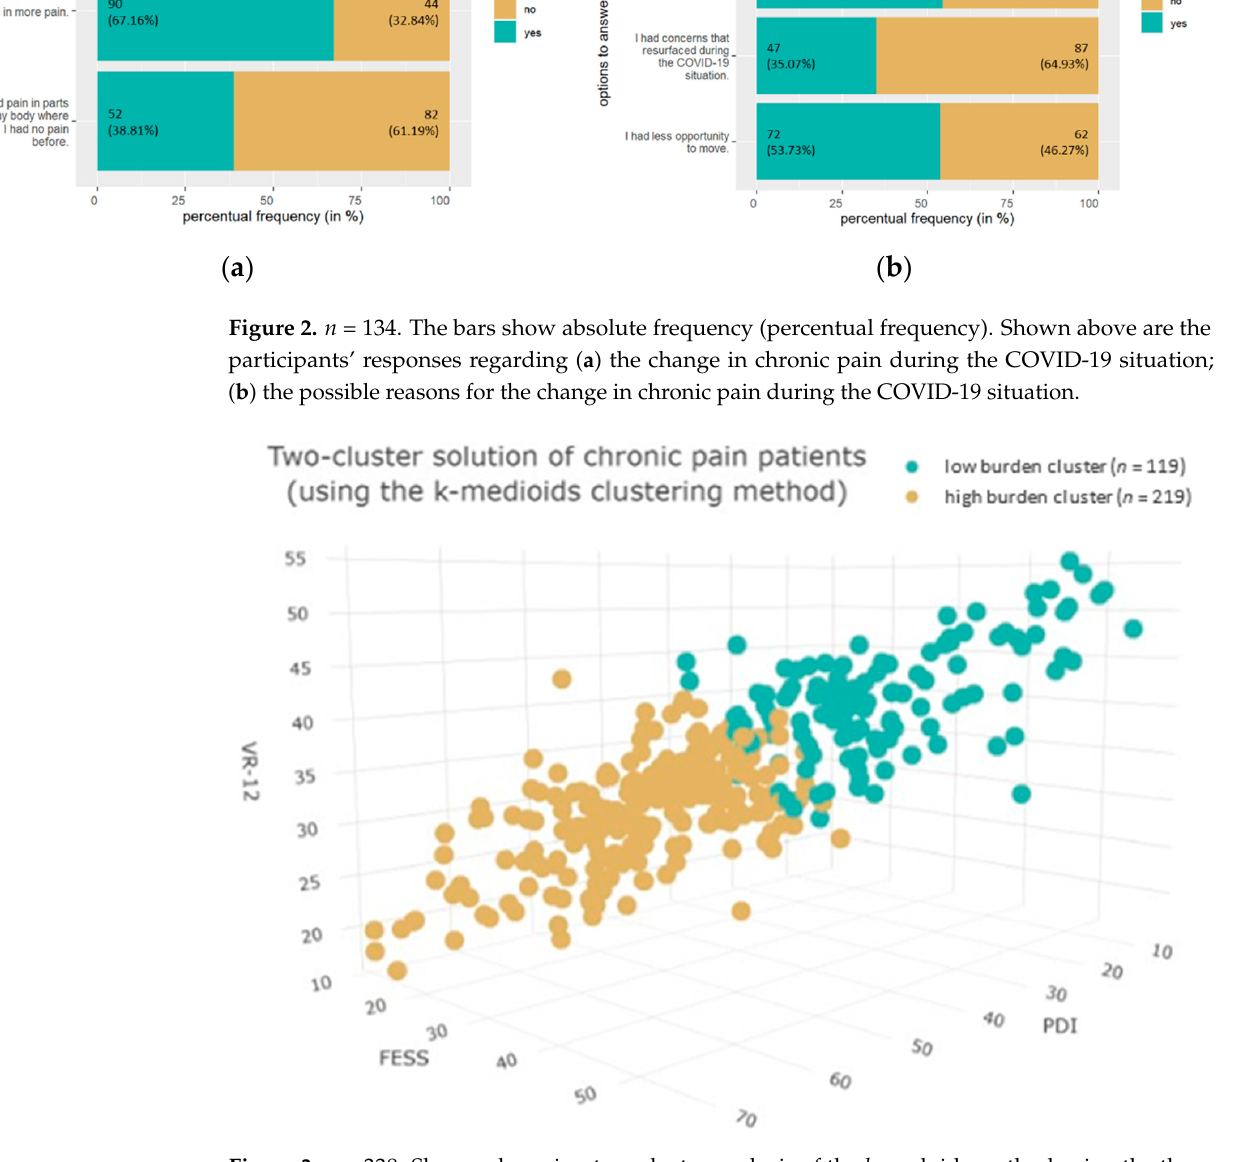
Figure 3. n = 338. Shown above is a two-cluster analysis of the k-medoids method using the three scales: PDI (perceived pain disability), FESS (pain-speci fi c self-e ffi cacy), and VR-12 (health-related quality of life), in a sample of patients with chronic pain. For the sake of simplicity, the two VR-12 subgroups MCS (mental component score) and PCS (physical component score) were summarized in a VR-12 total mean score.